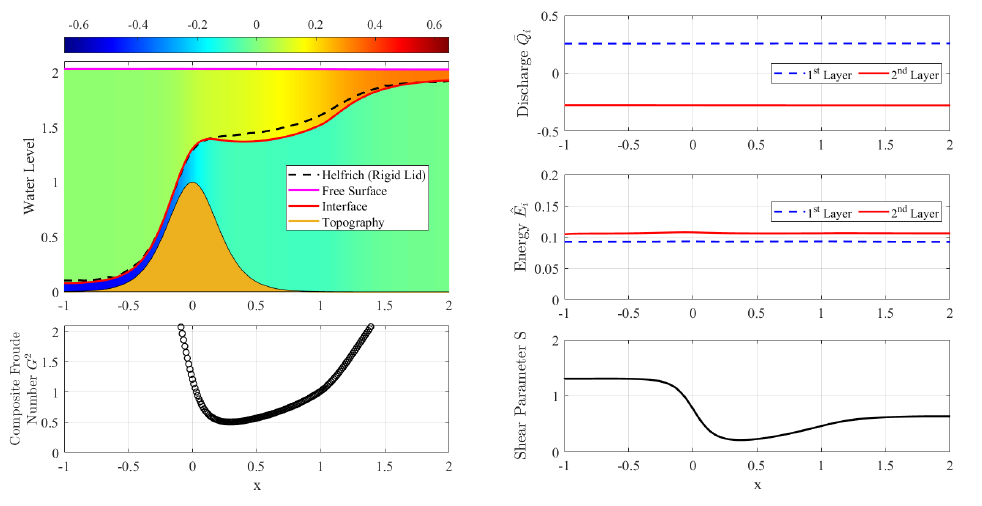
Figure 11. ( Left ) Steady interface in the exchange flow through channel with contraction and a bottom sill. ( Right ) Plots of discharge and energy for each layer; the shear parameter (10) is greater than one, indicating a loss of hyperbolicity in that